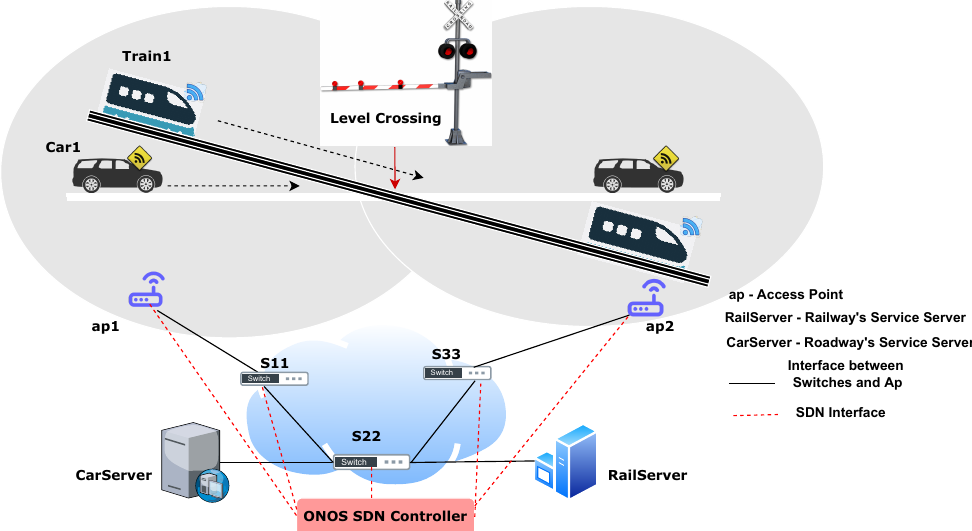
Figure 7. S4(5/6)4: Shared Access Network and Shared Core, Track Perpendicular to